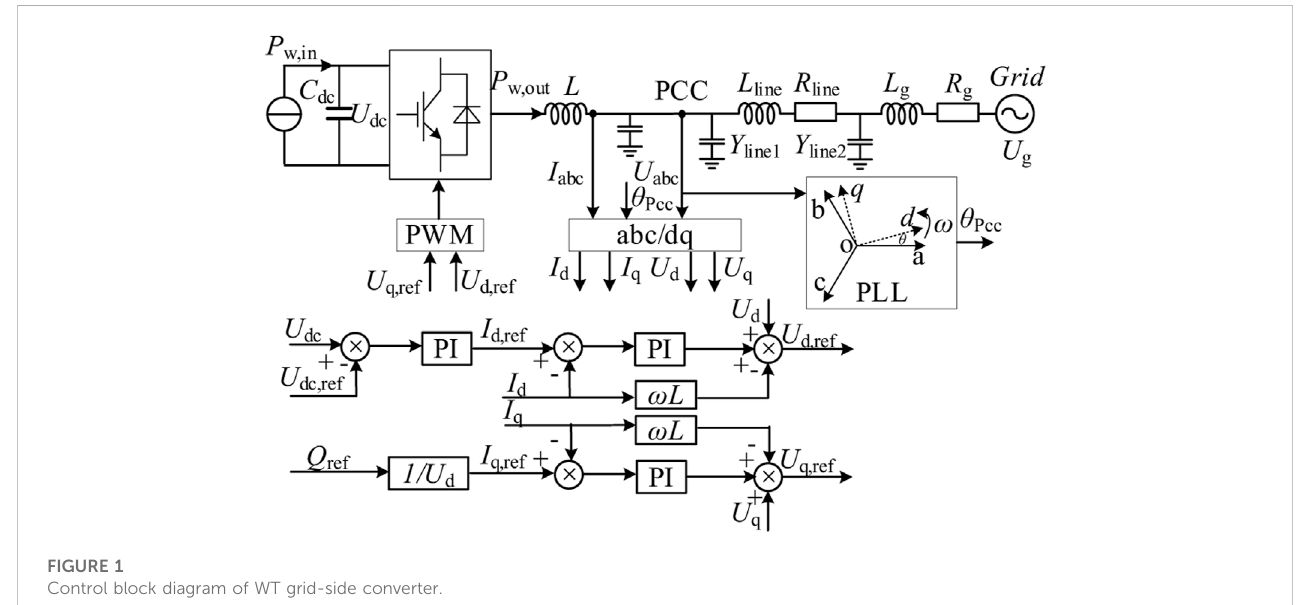
FIGURE 1 Control block diagram of WT grid-side